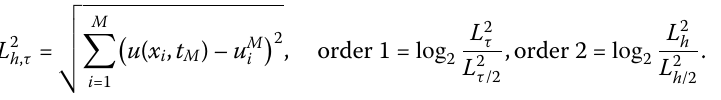
Figure 4 Distribution of DTE at space